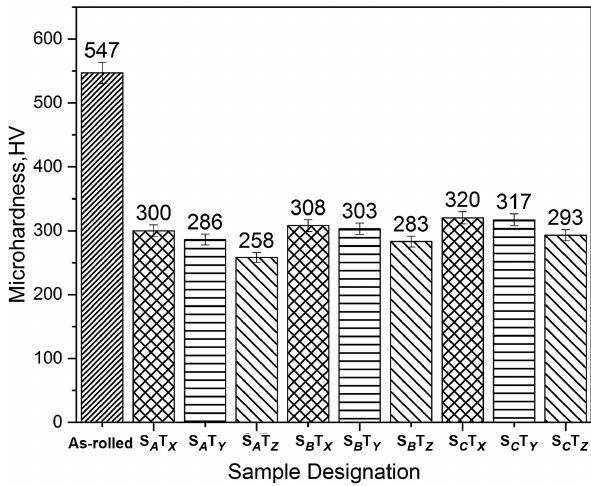
Figure 4: Hardness of T92 steel under different heat-treated condi- tions (heat treatment details are mentioned in Table